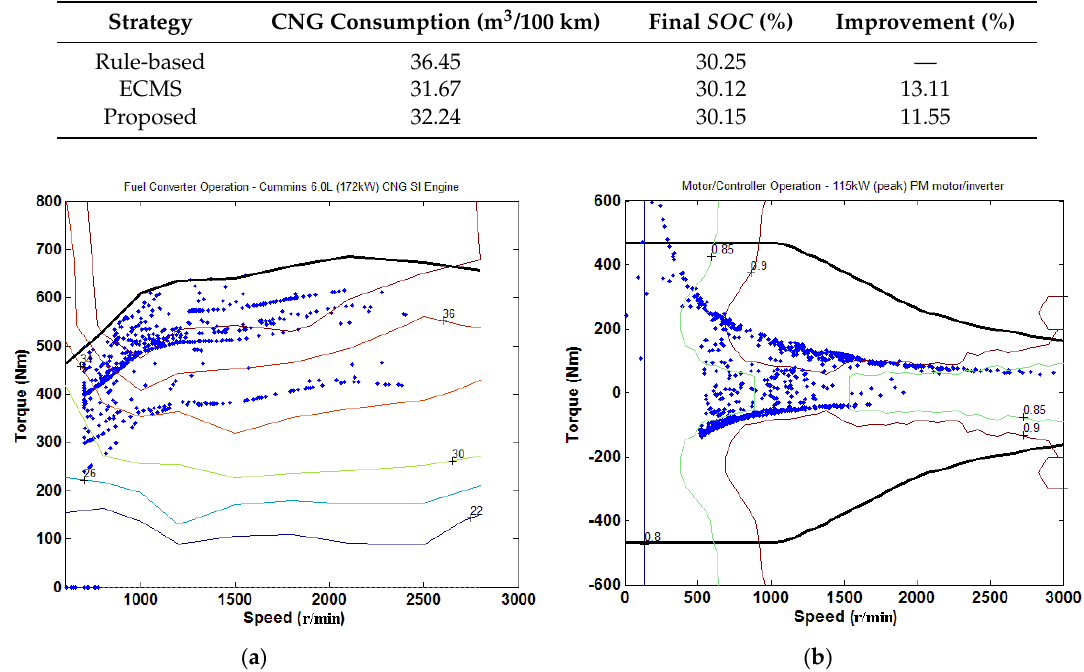
Figure 17. ( a ) Operating points of the engine; ( b ) Operating points of the EM.